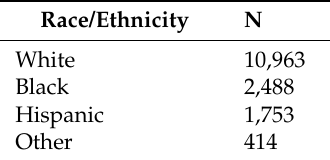
Table 1. Health and Retirement Study Sample Characteristics.